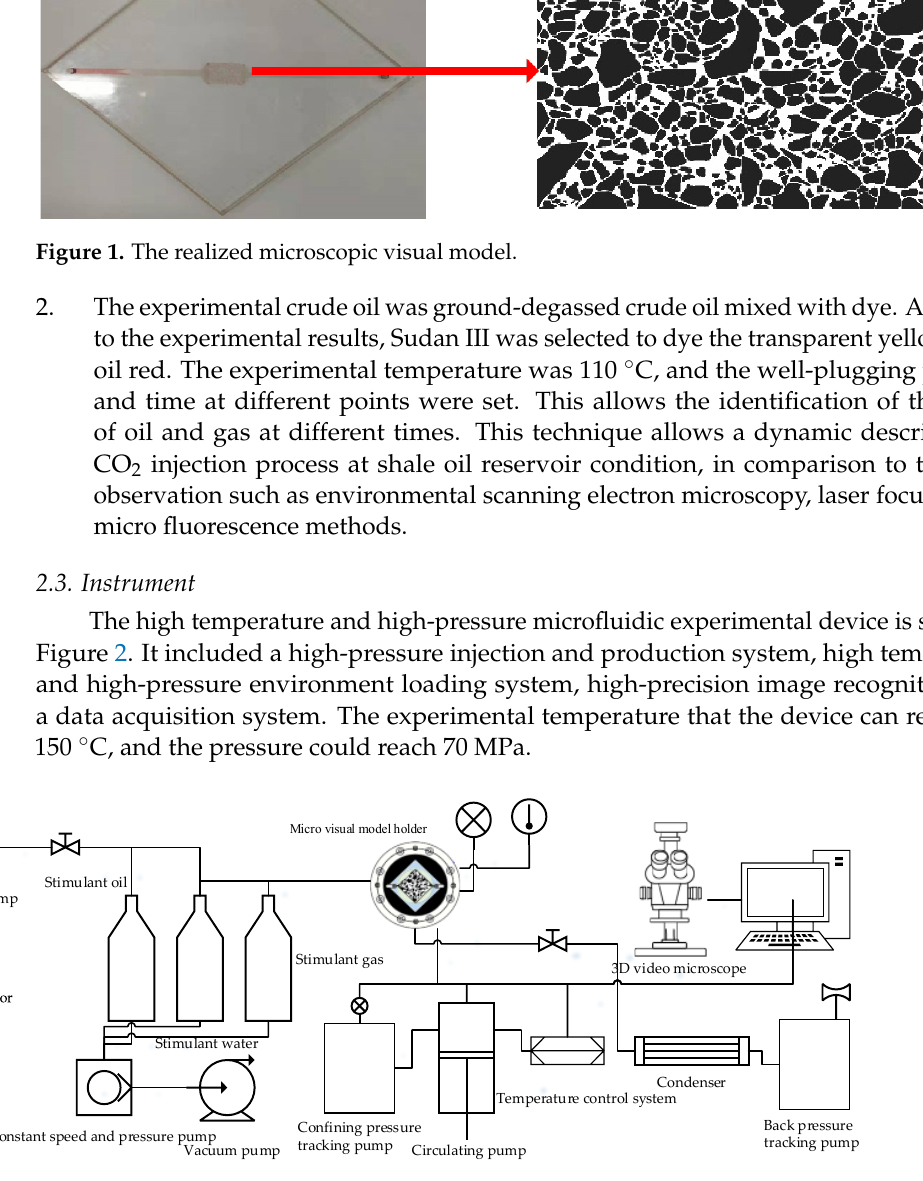
Figure 2. Flow chart of the micro visualization experimental device. The injection pump injected the displacement medium into the microchannel chip at a constant speed and pressure, simulated the temperature and pressure conditions of the real reservoir through the confining pressure tracking pump, circulating pump and tem- perature control system, and used a high precision back pressure pump to control the outlet pressure. The image of developing time elapsing in the displacement process in the micro-scale channel was recorded by video microscope, and the experimental results were analyzed quantitatively by image processing technology.